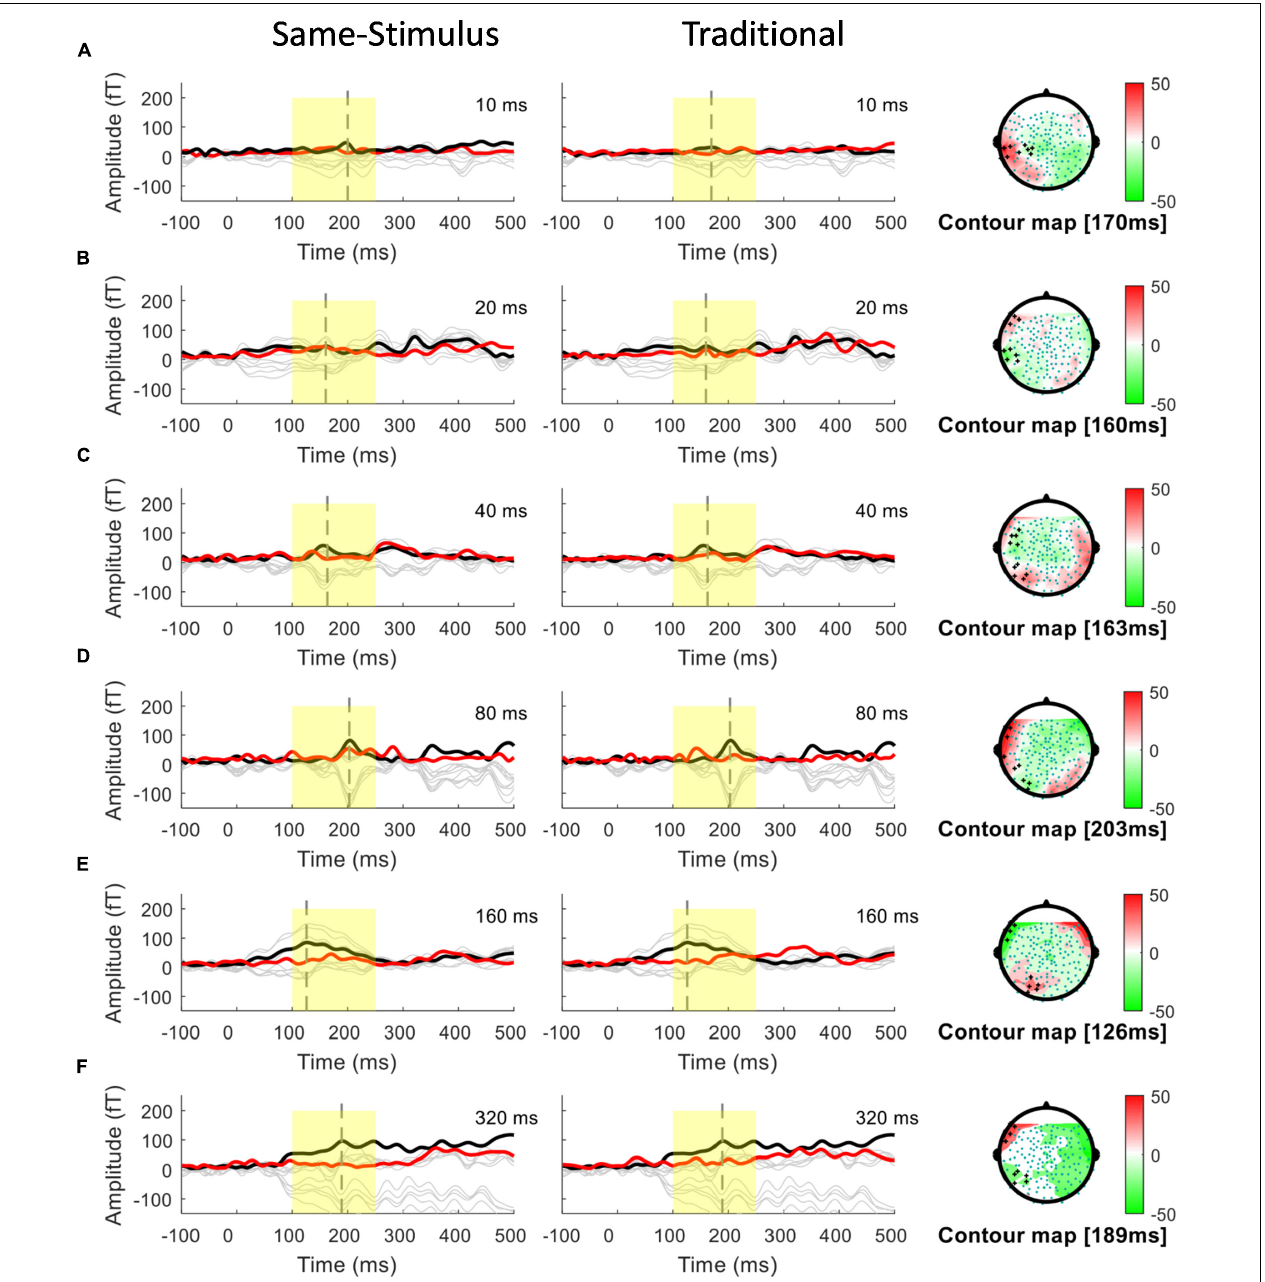
FIGURE 2 | Overlays of average standard (red line) and deviant (black line) magnetic field waveforms from a representative participant for each upward FM-sweep duration condition in the left hemisphere. The red lines are the RMS of the standard waveforms that were measured from the 10 selected sensors that showed the field patterns of MMNm. The topographical maps (right) show the differential activities of the mismatched waveforms corresponding to each sweep condition. MMNm response is elicited similarly using the same-stimulus (left) and traditional (middle) methods. Standard and deviant waveforms elicited by (A) 10-ms sweep